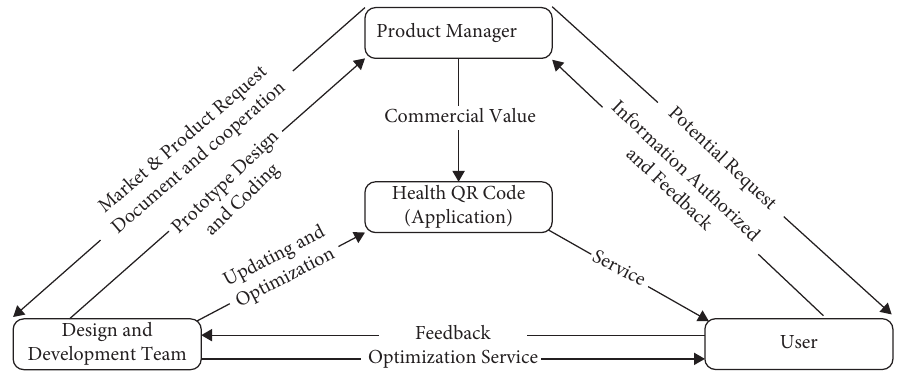
Figure 2: Tripartite game